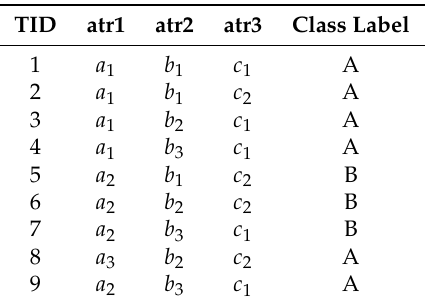
Table 2. A sample